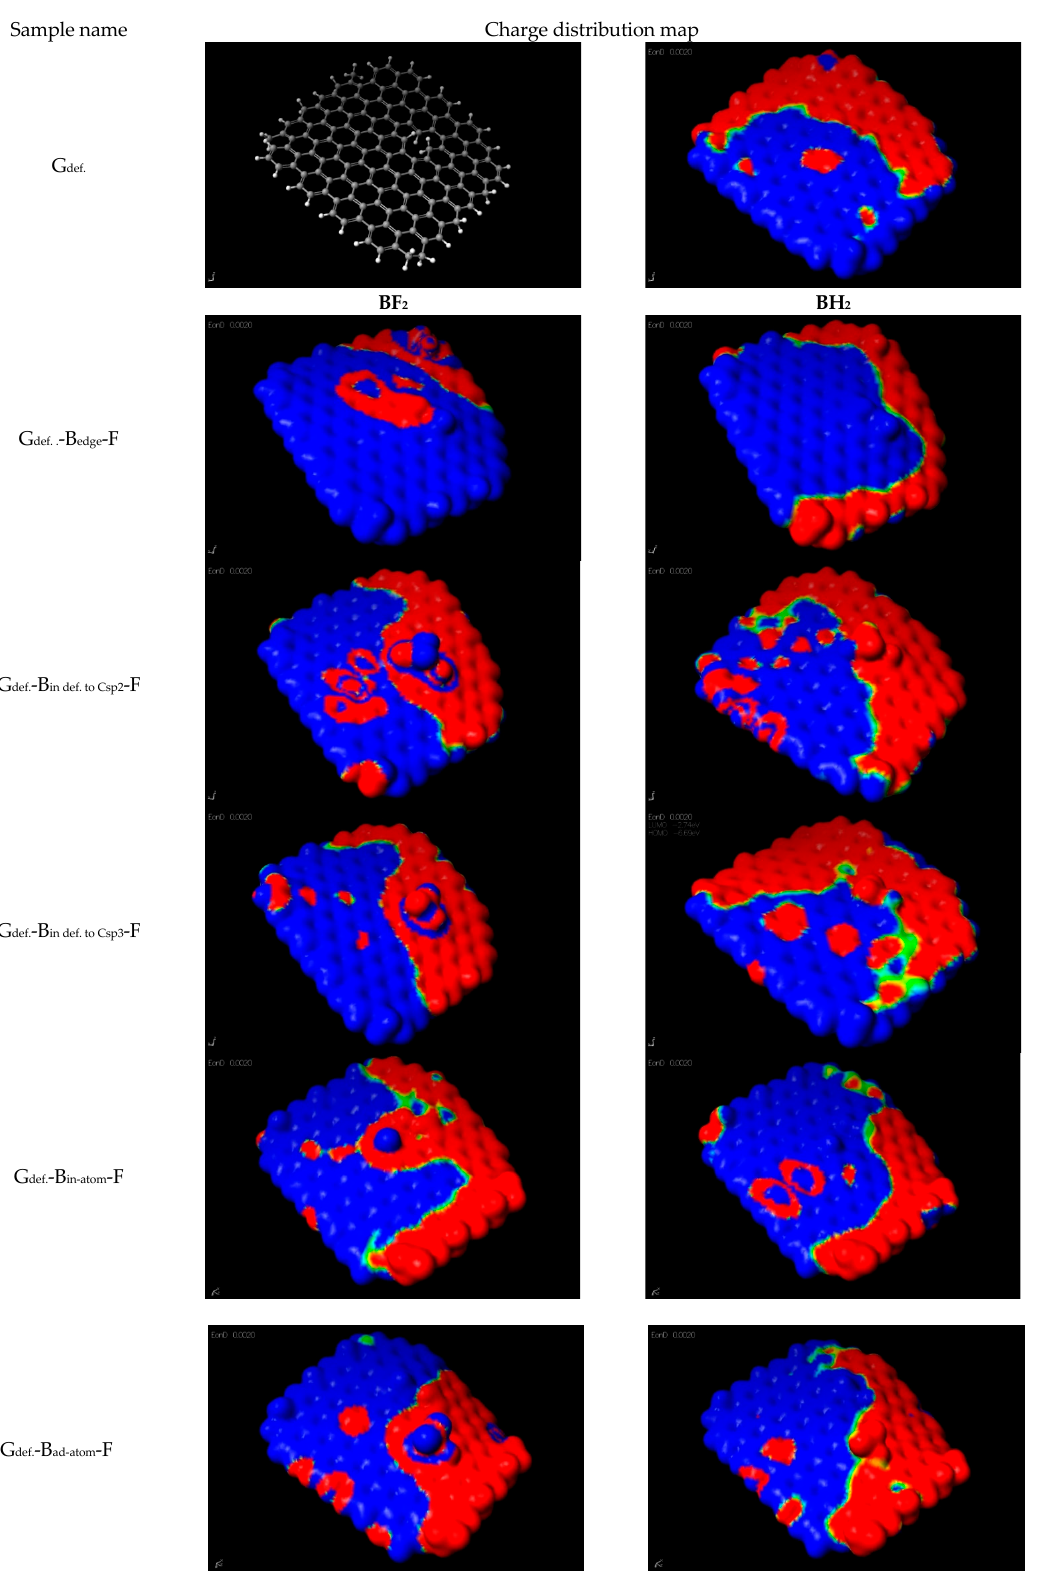
Figure 2. Comparison of distribution of electrostatic potential of the analyzed graphene systems depending on the place of attachment of -BF 2 groups or the formation of -BH 2 groups, according to the nomenclature described in Table 2. In the areas of graphene where the reaction with the BF 3- ion produces the -BF 2 group, there is a growth of negative zones. Additionally, there is a clearly marked tendency to occupy the central zones of the graphene flake by a negative charge. A similar relationship was found by X. Duan, K. O'Donnell [30], who analyzed graphene systems doped with sulfur and/or nitrogen. Then, for the most thermodynamically stable system (G def.-Bad-atom-F-described in Table 2), taking into account the electrostatic relations, the interaction energy with the lithium ion as a function of its distance from the graphene structure was examined (Figure 3). It was assumed that the lithium ion would only interact with the structure of functionalized graphene. In this case, the transport of the shielded lithium through the electrolyte and its interaction with the SEI layer of the lithium-ion battery was omitted. Figure 3. The interaction energy of lithium ions with the structure of Graphene functionalized with -BF 2 group (G def. -B ad-atom -F—according to the nomenclature described in Table 2). For such assumptions, it was found that the change in the electrostatic potential of the functionalized graphene flake (C graphene -BF 2 chemical bond) causes the physical interaction of graphene with the lithium cation. The consequence of this phenomenon is the reduction in the system energy as a result of the electrostatic attraction of Li + by the areas of electrostatic interaction of fluorine. This phenomenon explains why it is possible to achieve a relatively thermodynamically stable physical lithium bond in modified graphene systems—as opposed to unmodified graphene systems. Although the energy of